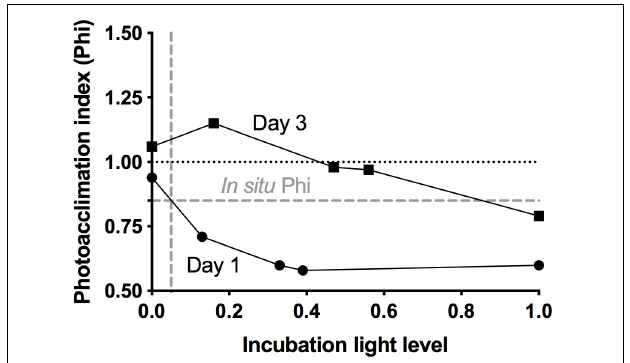
FIGURE 4 | Photoacclimation index (Phi), calculated from flow cytometry measurements of 24 h changes in red fluorescence to forward scatter ratios, as a function of incubation light level, for day 1 and day 3 at station 4 (NAAMES II). Dashed gray lines show calculated in situ Phi and corresponding inferred in situ light level for day